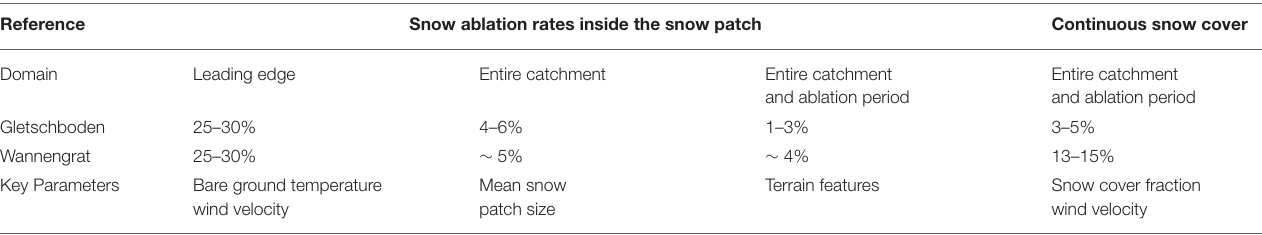
TABLE 2 | Fraction of above-average snow ablation rates [%] relative to snow ablation rates inside the snow patch and relative to a continuous snow cover for the Gletschboden and Wannengrat test site due to lateral transport processes at the leading edge of a snow patch, for the entire catchment and for the entire catchment and ablation